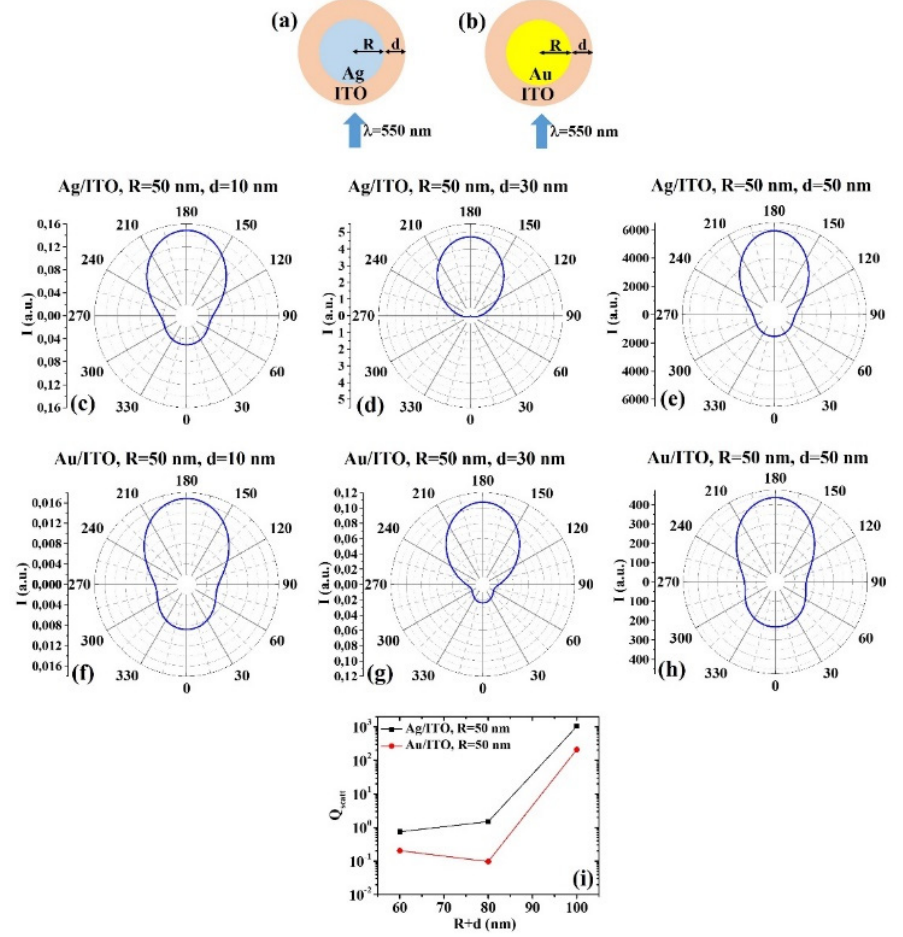
Figure 6. ( a , b ) Scheme of the structure of the simulated Ag/ITO ( a ) and Au/ITO ( b ) core–shell spherical particle with core radius R and shell width d and electromagnetic radiation of wavelength λ = 550 nm impinging on the particle from 0 ◦ . ( c – e ) Calculated polar diagrams for the intensity of the scattered light from the Ag/ITO core–shell spherical particle fixing the Ag core radius R to 50 nm and increasing the ITO shell width from 10 nm to 50 nm. ( f – h ) Calculated polar diagrams for the intensity of the scattered light from the Au/ITO core–shell spherical particle fixing the Au core radius R to 50 nm and increasing the ITO shell width from 10 nm to 50 nm. ( i ) Calculated scattering efficiency for the light (wavelength λ = 550 nm) scattering process of the Ag/ITO (black dots) and Au/ITO (red dots) core–shell spherical particles fixing the core radius to R = 50 nm and increasing the ITO shell width d from 10 nm to 50 nm. (c) R = 70 nm: Figure 7a, b reports the scheme of the structure of the simulated Ag/ITO (Figure 7a) and Au/ITO (Figure 7b) core–shell spherical particle with core radius R and shell width d and electromagnetic radiation of wavelength λ = 550 nm impinging on the particle from 0°; in Figure 7c–e the calculated polar diagrams for the intensity of the scat- tered light from the Ag/ITO core–shell spherical particle fixing the Ag core radius R to 70 nm and increasing the ITO shell width from 10 nm to 50 nm are reported; in Figure 7f–h the calculated polar diagrams for the intensity of the scattered light from the Au/ITO core– shell spherical particle fixing the Au core radius R to 70 nm and increasing the ITO shell